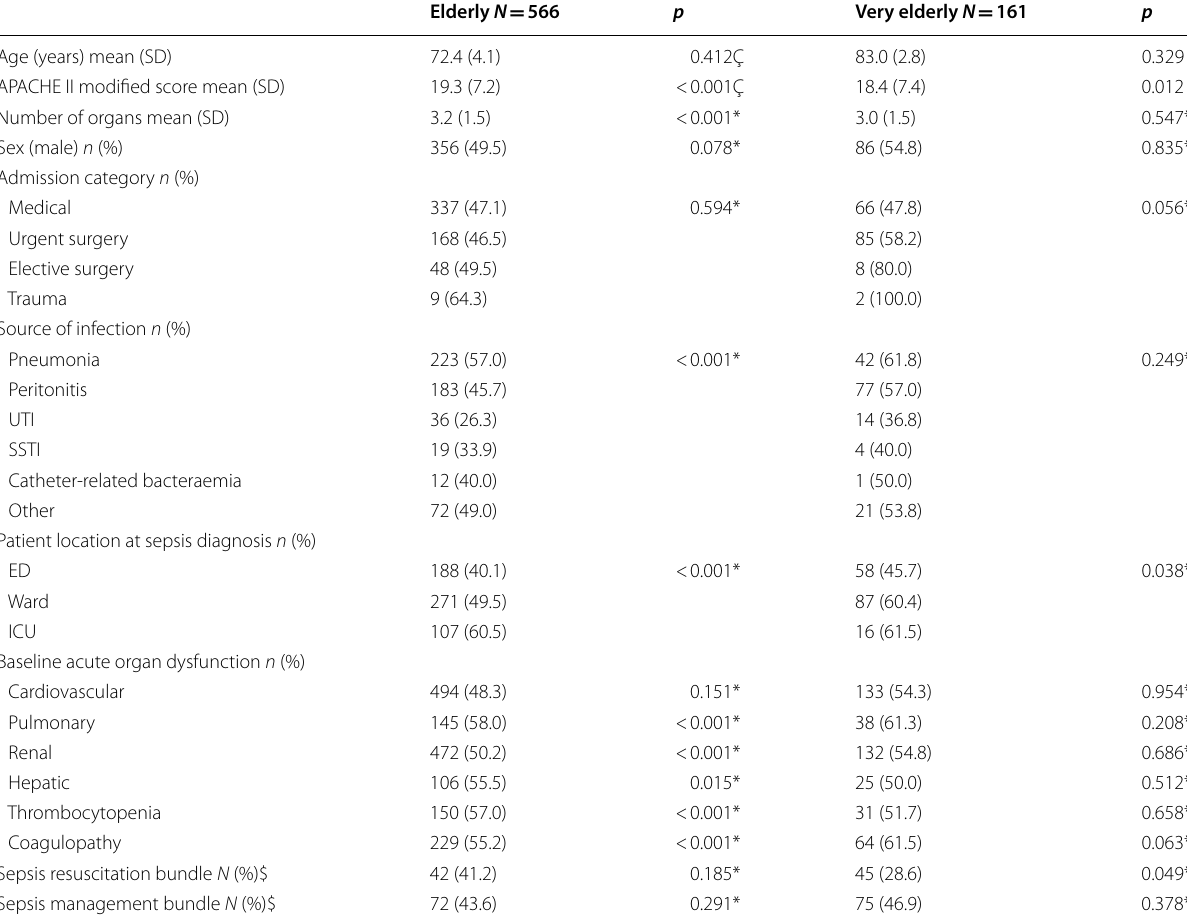
Table 2 Risk factors for hospital mortality between elderly and very elderly